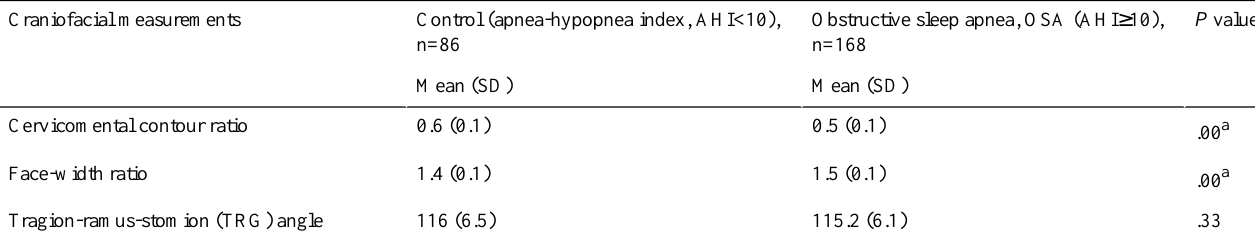
Table 10. Contrast among control and obstructive sleep apnea (OSA) groups on the male (N=254)